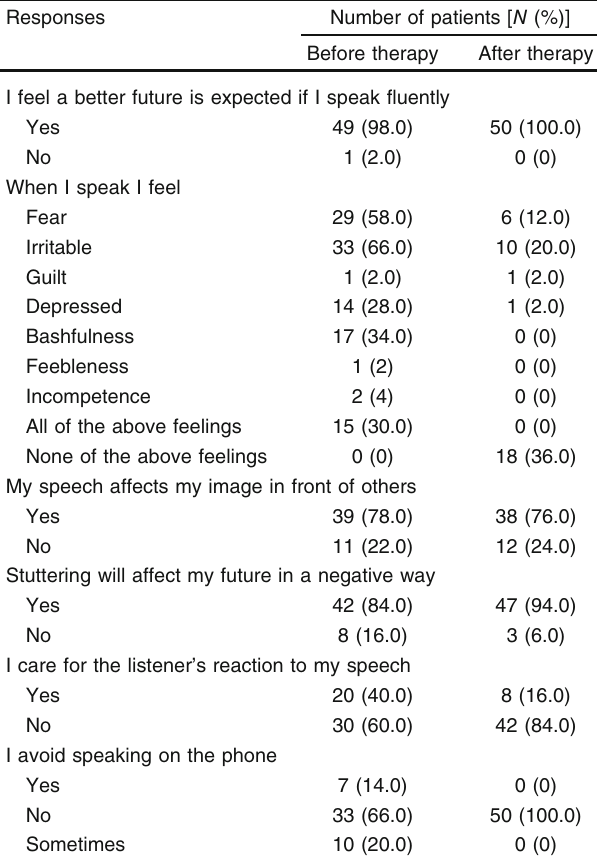
Table 15 Results of the speech performance questionnaire in the study group before and after